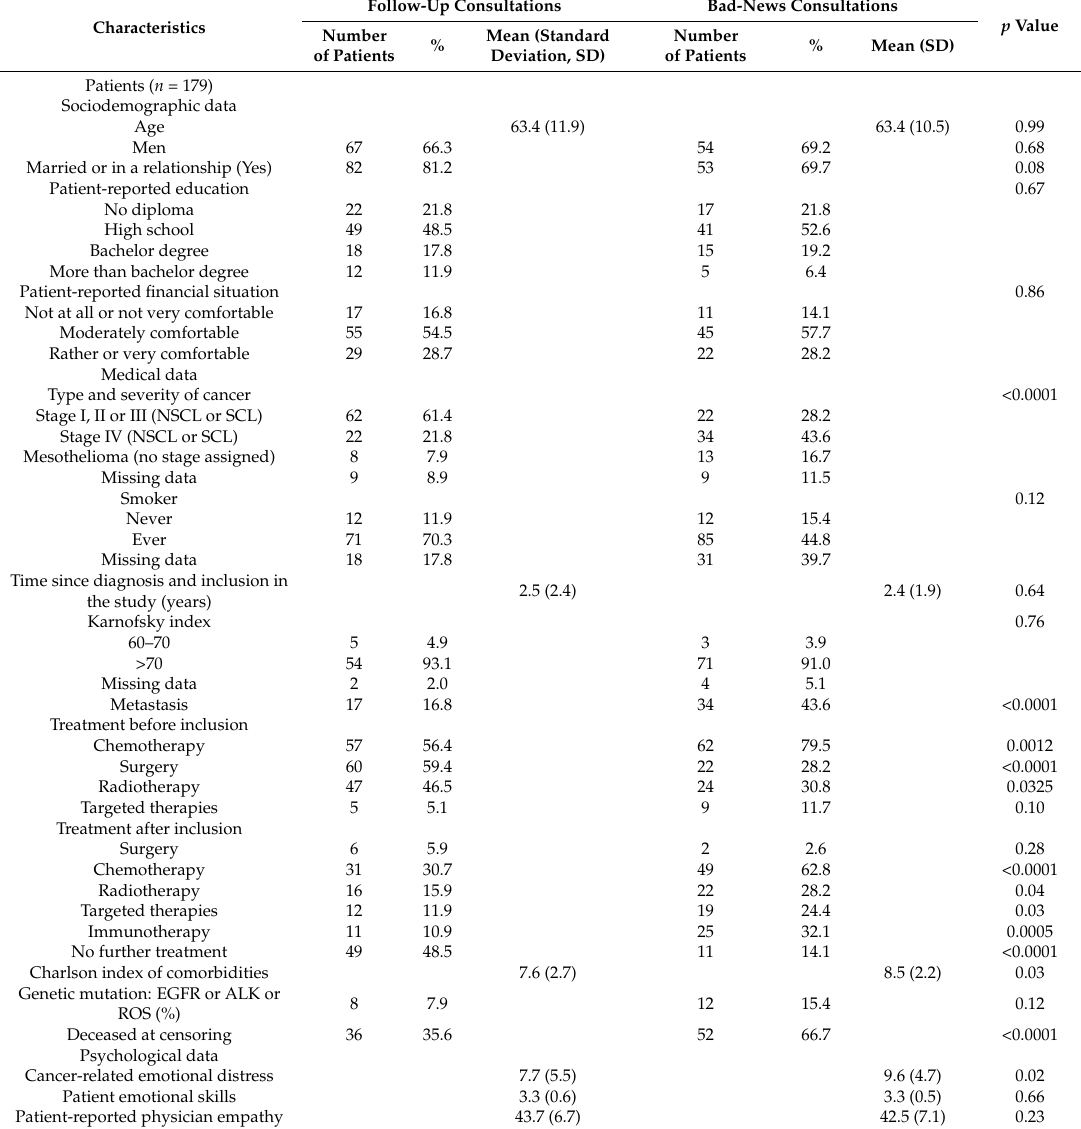
Table A1. Characteristics of patients in follow-up versus bad news